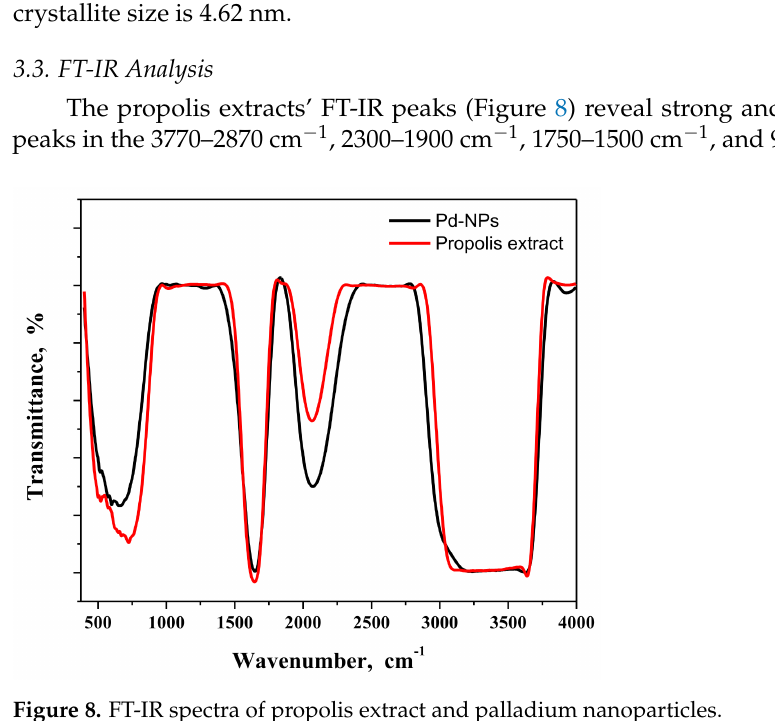
Figure 8. FT-IR spectra of propolis extract and palladium